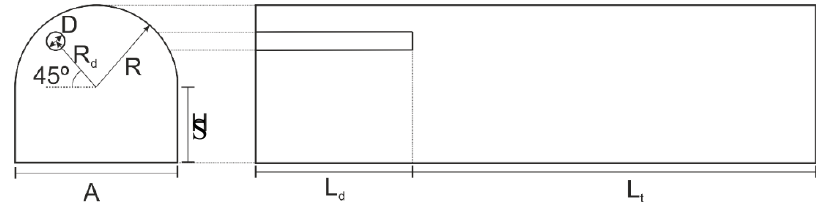
Figure 3. Definition of the parameters. Tunnel view: Left, lateral; right,